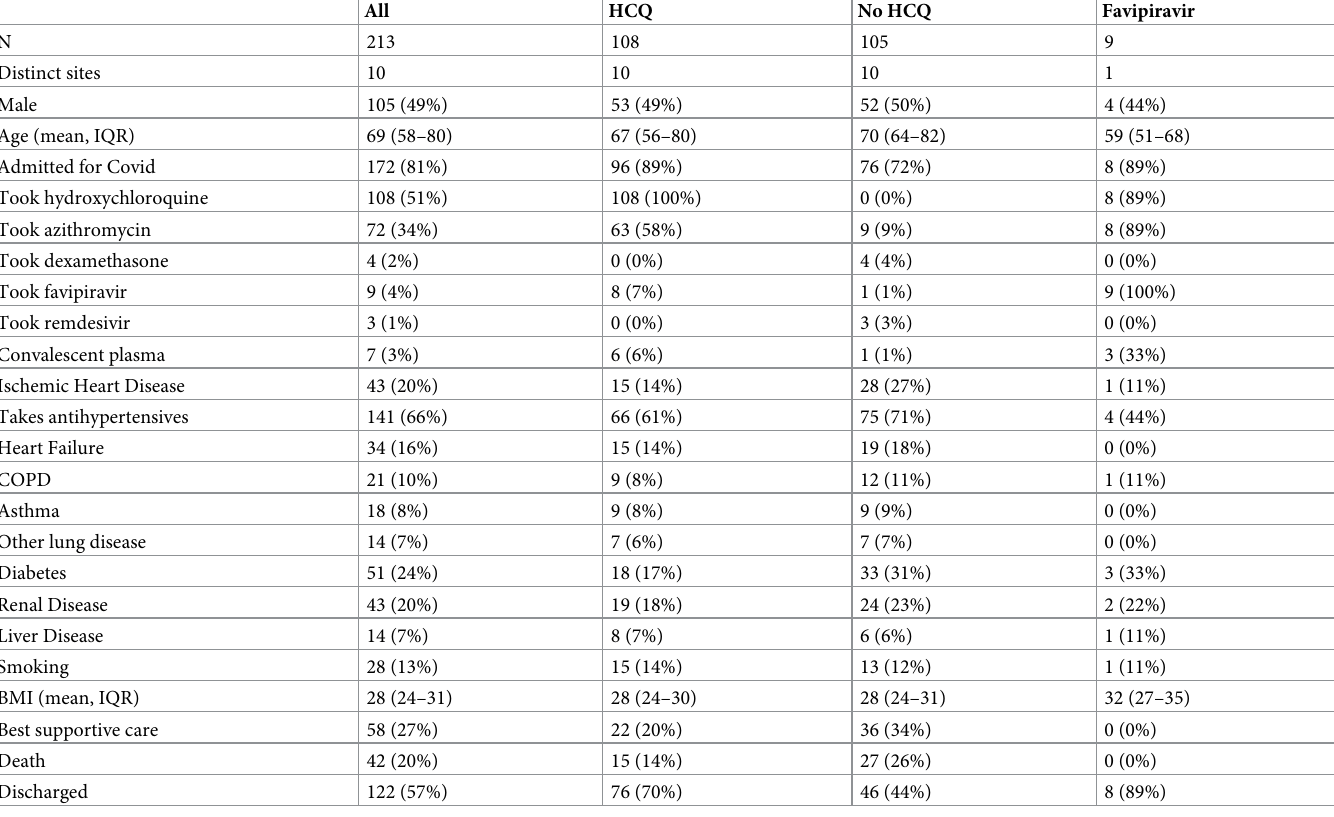
Table 1. Patient characteristics for the overall sample and treatment subgroups. Note that the favipiravir subgroup is not exclusive with either the HCQ or No HCQ group. All HCQ No HCQ Favipiravir